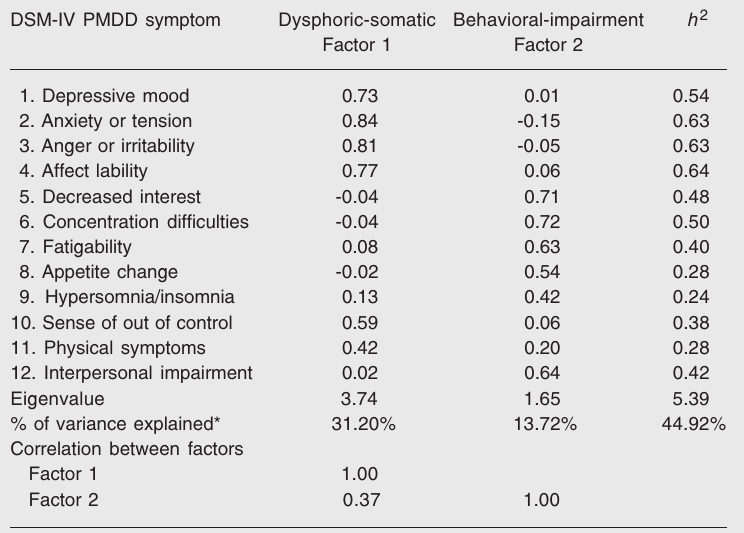
Table 2. Component pattern matrix after direct Oblimin rotation from principal compo- nent analysis of premenstrual dysphoric disorder (PMDD) symptoms in a population of college students (N = 316). DSM-IV PMDD